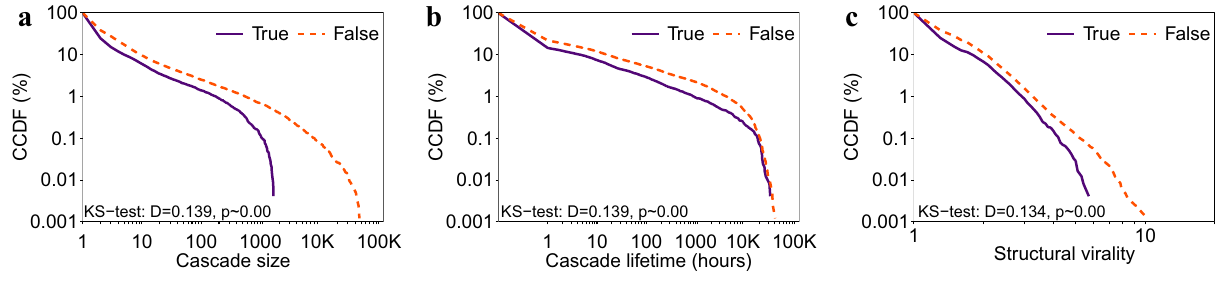
Figure 1. Complementary cumulative distribution functions (CCDFs) for different diffusion properties of social media cascades, namely, cascade size ( a ), cascade lifetime ( b ), and structural virality ( c ).